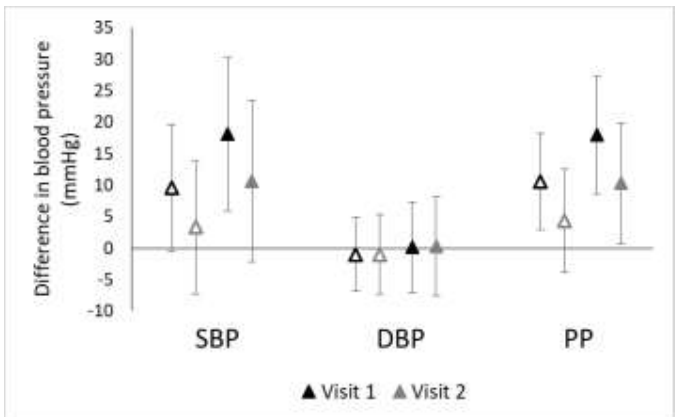
Figure 4. Effect estimates for the association of ln(TAA-PNC) with blood pressure measures for participants in Somerville and Dorchester/South Boston who attended two clinic visits ( n = 205). Open markers represent unadjusted associations (Model A) while solid markers represent adjusted associations (Model B; adjusted for BMI, sex, smoking, physical activity, and diet as fried food consumption).